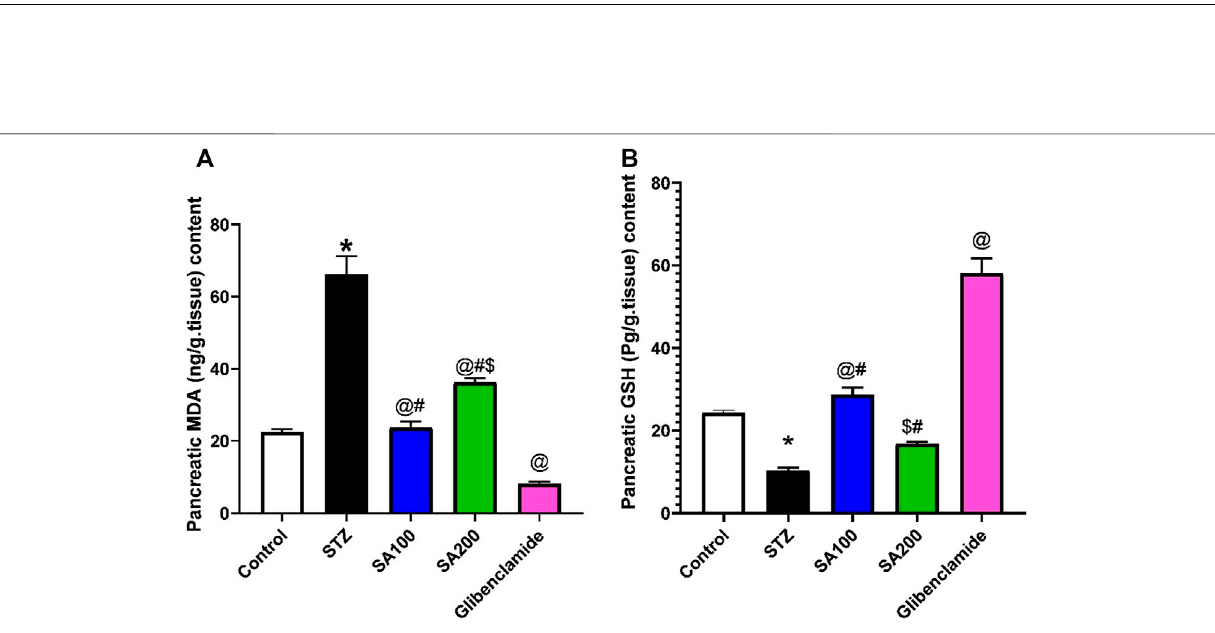
Frontiers in Pharmacology |